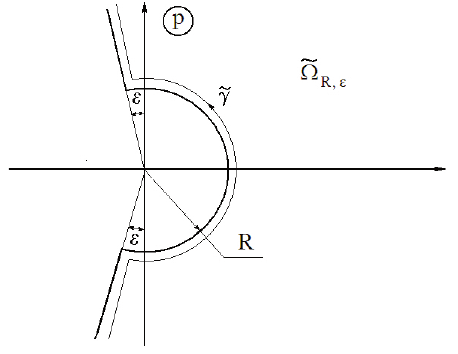
Figure 1. Integration